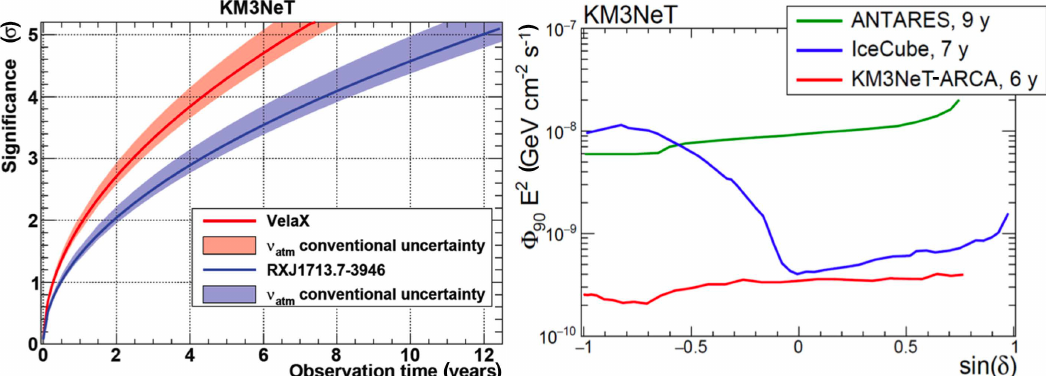
Figure 6. Left : Significance as a function of KM3NeT-ARCA (two building blocks) observation time for the detection of the galactic sources RXJ1713 and Vela-X. The bands represent the effect of the uncertainties on the conventional component of the atmospheric neutrino flux. Right : KM3NeT-ARCA (two building blocks) 5-s discovery potential as a function of the source declination (red line) for one neutrino flavor, for point-like sources with a spectrum E − 2 and three years of data taking. For comparison, the corresponding discovery potential for the IceCube and ANTARES detector (blue and green line, respectively) is